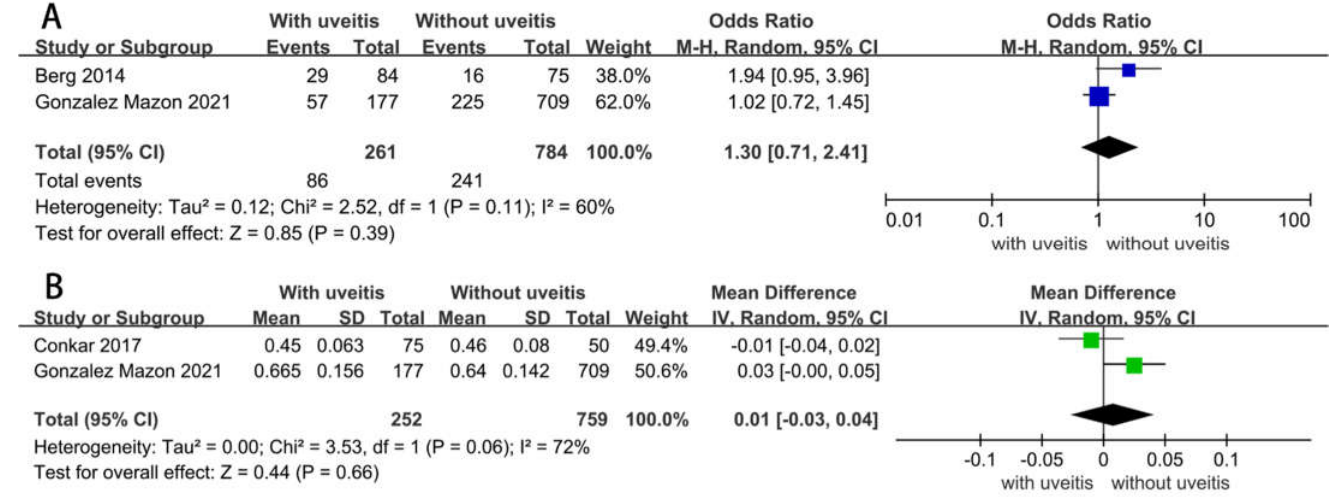
Figure 2. ( A ) Forest plots showing pooled OR with 95% CI of carotid plaques for patients with uveitis versus those without. ( B ) Forest plots showing pooled MD with 95% CI of cIMT for patients with uveitis versus those without.